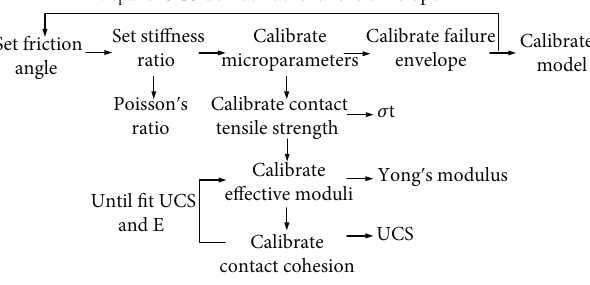
Figure 3: The “ trial and error ” method parameter checking process of the PFC model [27].